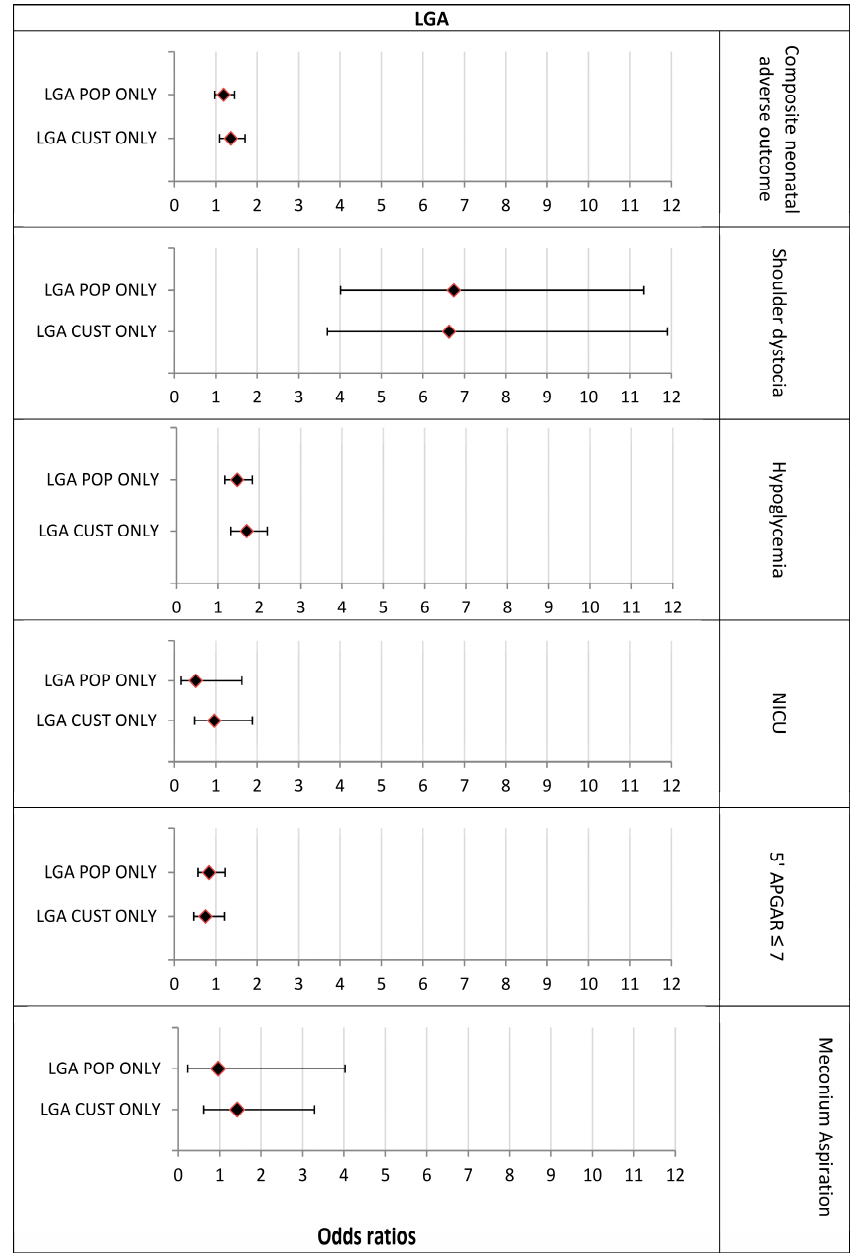
Figure 5. The association between LGA group categorization and adverse neonatal outcomes (Odds ratios, 95% CI). The customized models are adjusted for maternal age.